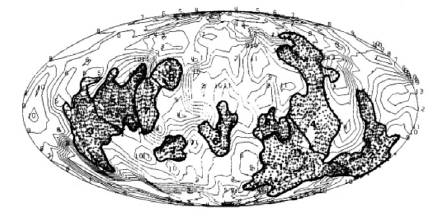
Fig. 19. Mollweide projection for the surface